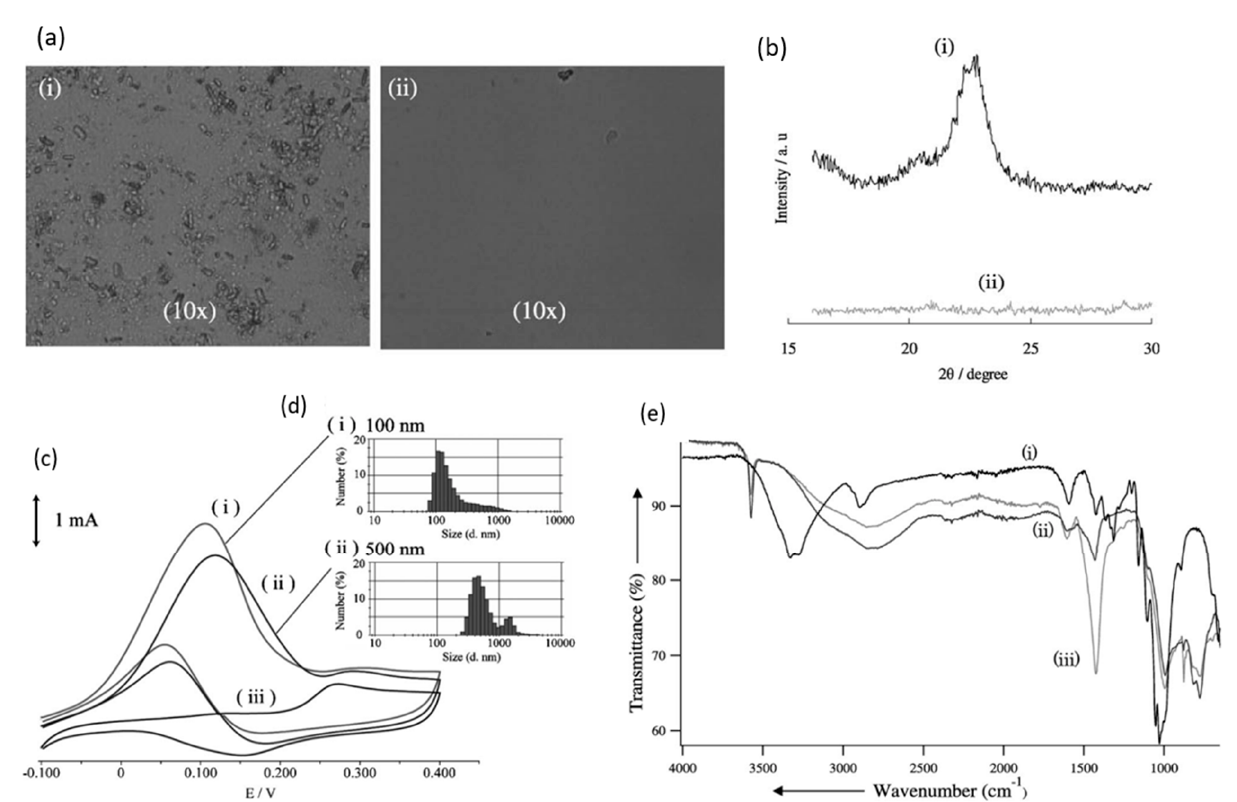
Figure 3. ( a ) Microscopic images before (i) and after (ii) dissolution. ( b ) X-ray diffraction of cellulose before (i) and after (ii) dissolution. ( c ) cyclic voltammogram (vs. Ag/AgCl) of cellulose ball milled to average particle size of 100 nm (i), 500 nm (ii) and without cellulose (iii). ( d ) size distribution after ball milling to 100 nm (i) and 500 nm (ii). ( e ) FTIR scans of cellulose before dissolution (i), after dissolution (ii) and after oxidation (iii). Reprinted with permission from Ref. [34]. Copyright 2010, Electroanalysis.